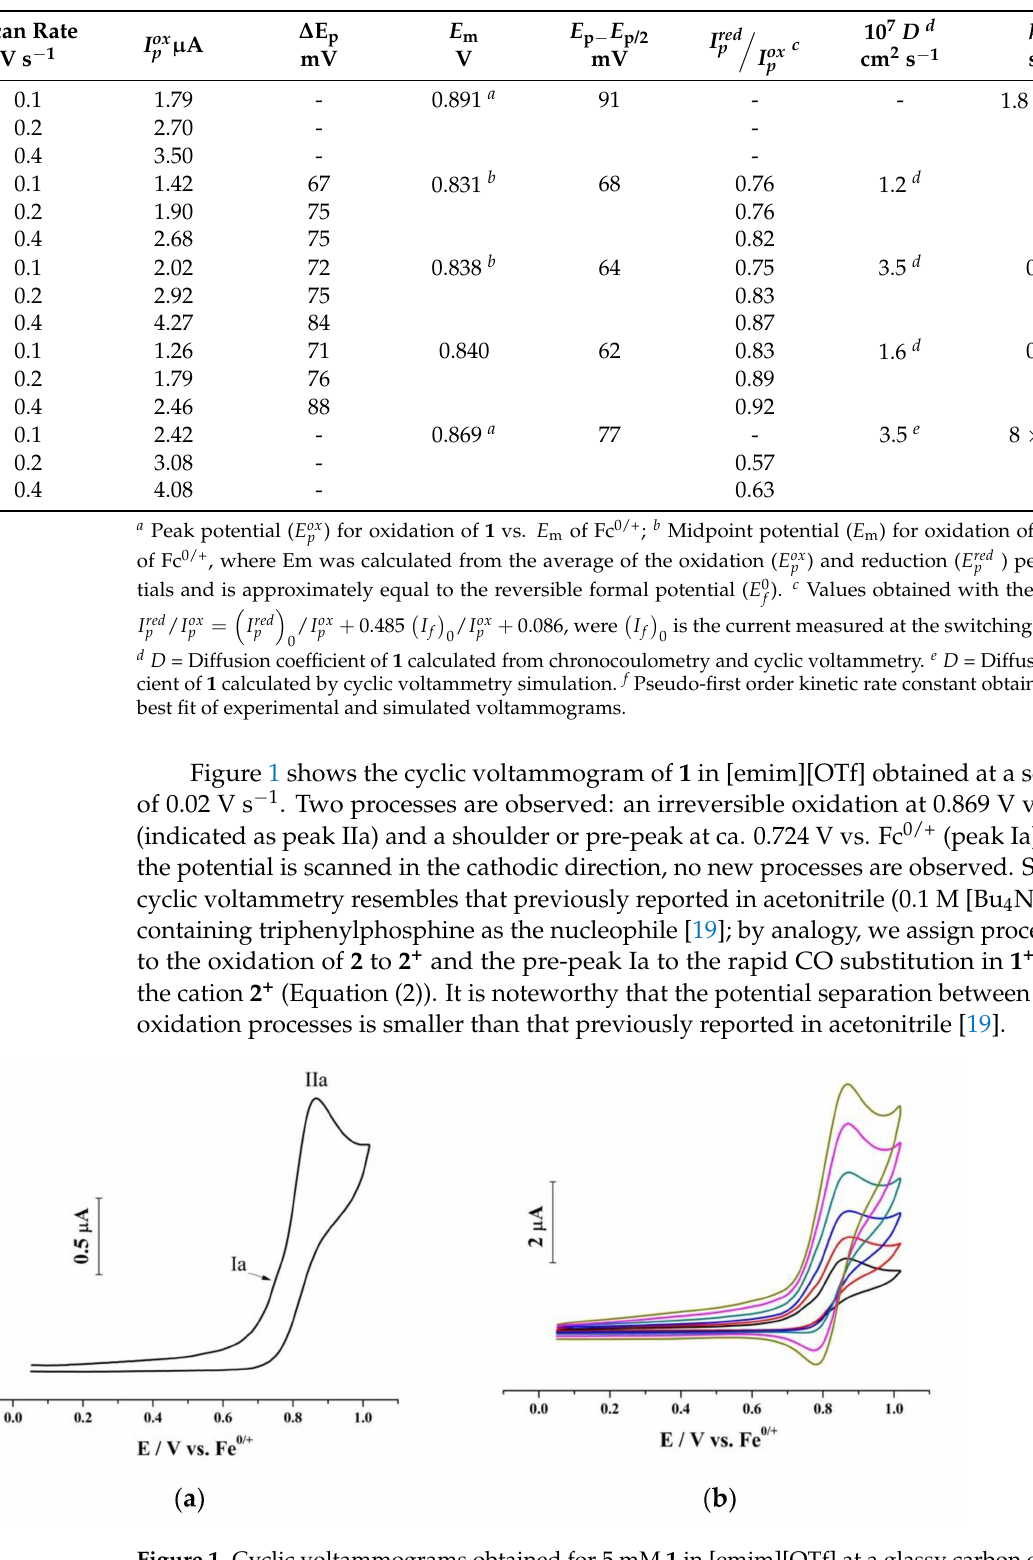
Figure 1. Cyclic voltammograms obtained for 5 mM 1 in [emim][OTf] at a glassy carbon electrode (d = 1 mm). ( a ) over a wide potential range with a scan rate of 0.02 V s − 1 and ( b ) over the poten- tial region where the oxidation occurs at scan rates of 0.02, 0.05, 0.10, 0.20, 0.40, and 0.60 V s − 1 . T = 21 ± 1 ◦